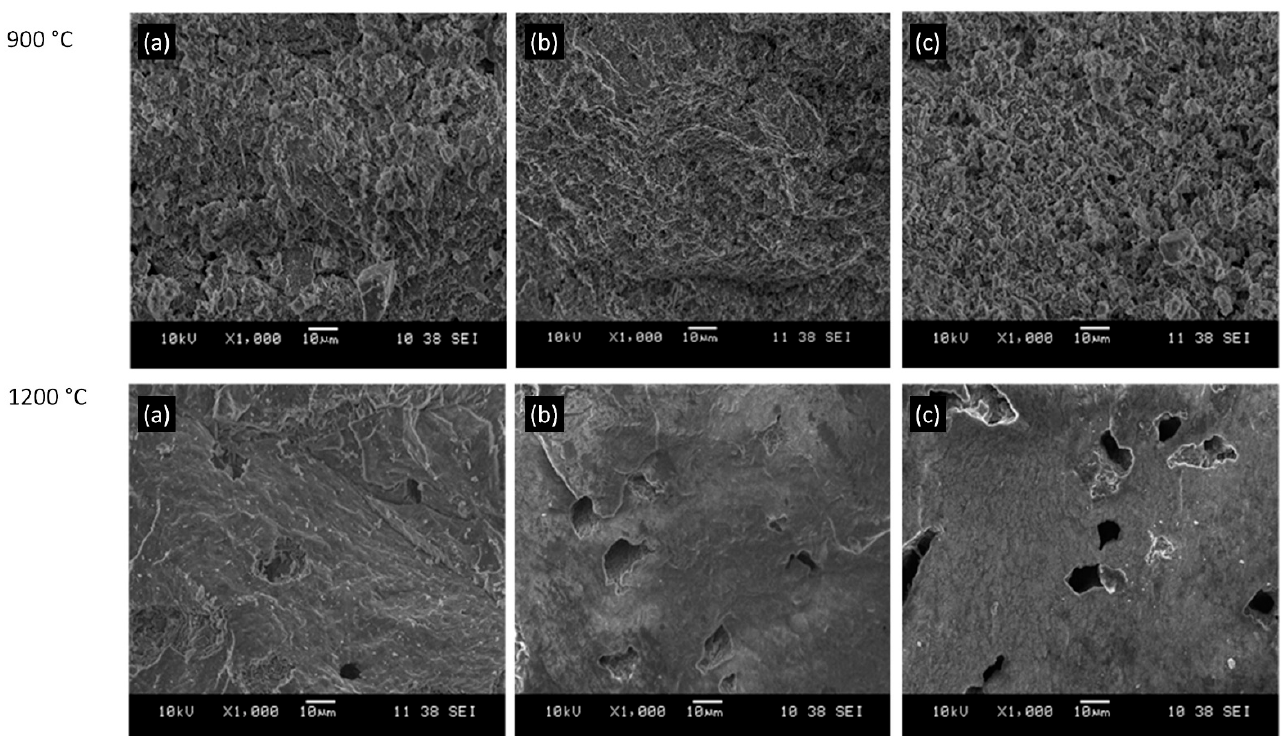
Figure 3. SEM micrograph of geopolymer-based nepheline ceramics sintered at 900 °C and 1200 °C with different heating rates of ( a ) 2 °C/min, ( b ) 5 °C/min and ( c ) 10 °C/min.